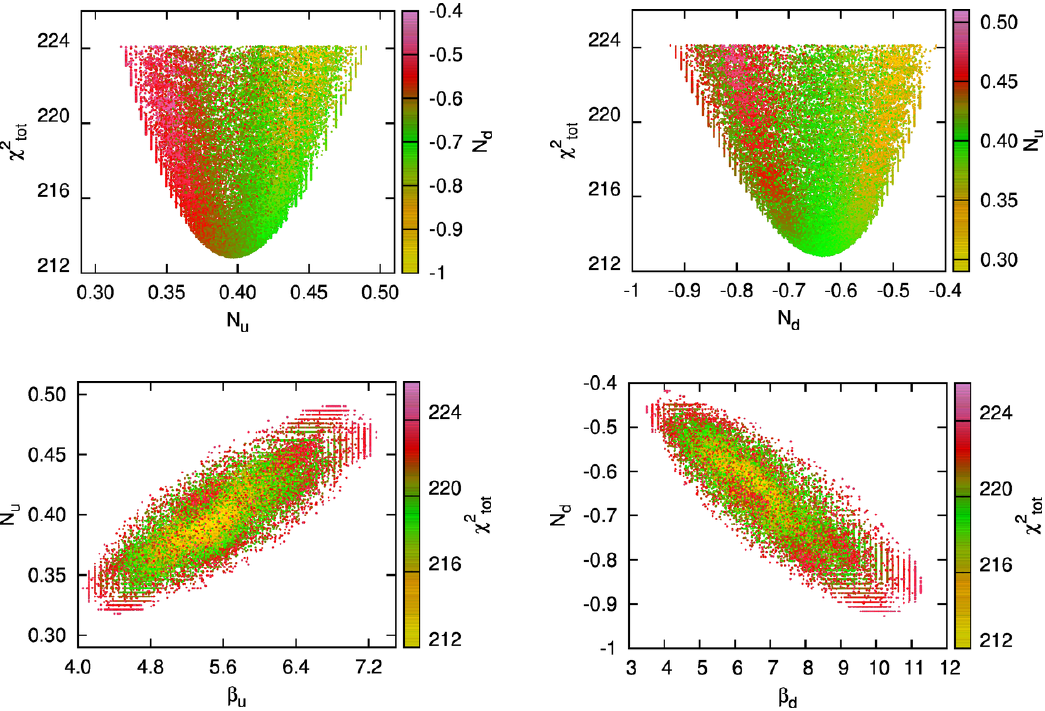
Figure 2 . Scatter plots representing the parameter space of the reference best (cid:12)t. The shaded regions correspond to our estimate of 2 (cid:27) C.L. error band.